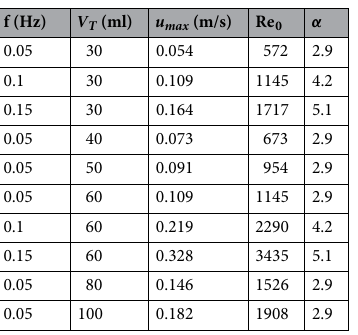
Table 2. Variation of flow parameters. Velocity, Reynolds numbers Re and Womersley numbers α , representing peak values in the 0th